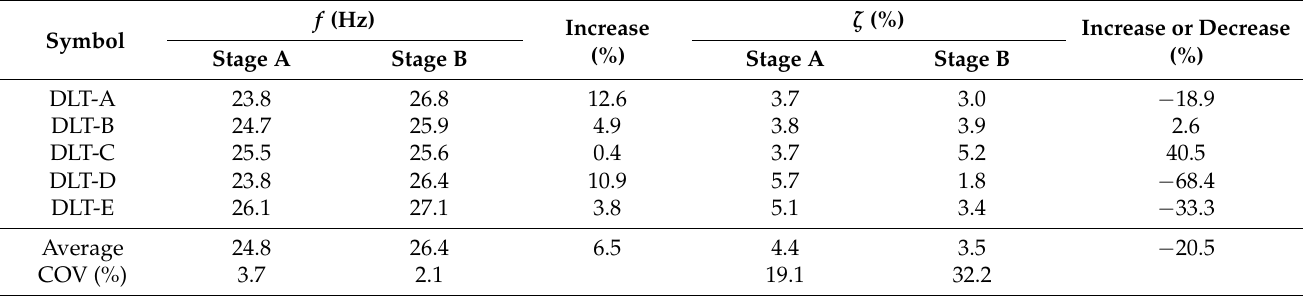
Table 2. The vibration characteristics of the large-scale DLT